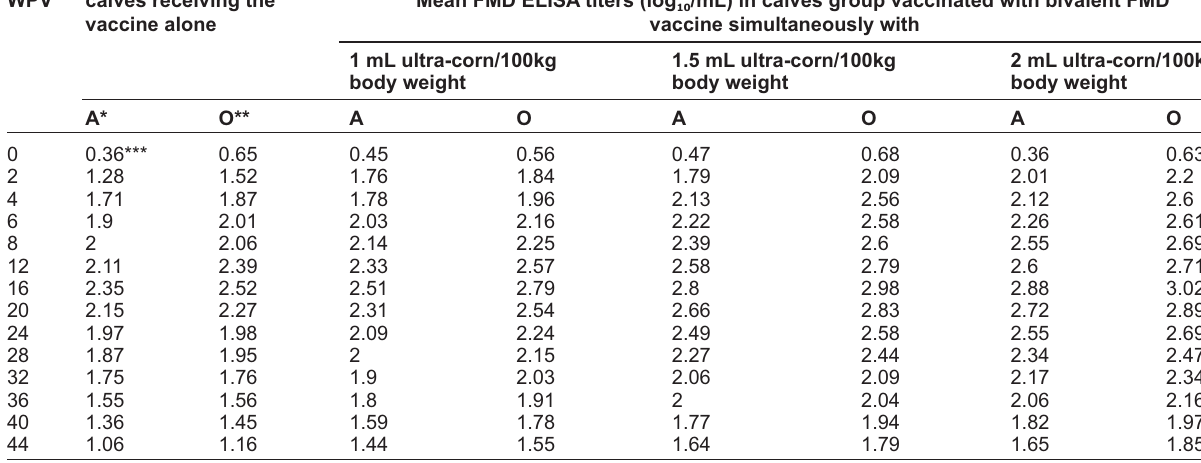
Table-2. Mean FMD ELISA antibody titer of calves vaccinated with bivalent FMD with ultra-corn simultaneous (locality A) WPV calves receiving the Mean FMD ELISA titers (log /mL) in calves group vaccinated with vaccine alone vaccine simultaneously